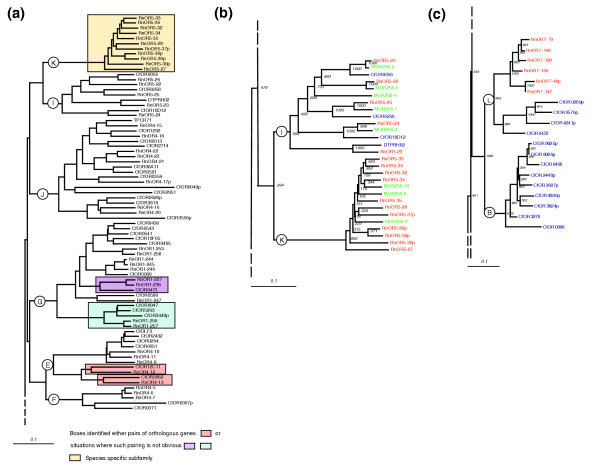
Analysis of OR families by phylogenetic comparison. OR sequences used to construct the phylogenetic trees correspond to the dog and rat sequences retrieved in this work or taken from [15] (human) and [19] (mouse). (a) Magnification corresponding to a part of family 2, including subfamilies E to G and I to K (general combined phylogenetic tree as provided in Additional data files 4 to 20). Circled letters identify dog and rat subfamilies. (b) Rat, dog and mouse subfamilies 2I and 2K (the corresponding subfamilies do not exist in humans). Rat genes are in red, dog genes in blue and mouse genes in green. (c) Subfamilies 6AL and 6B (note that subfamily 6AL is present in rat and dog repertoires but is absent from the human and mouse repertoires and that subfamily 6B is present only in the dog repertoire). The color code is the same as in (b).